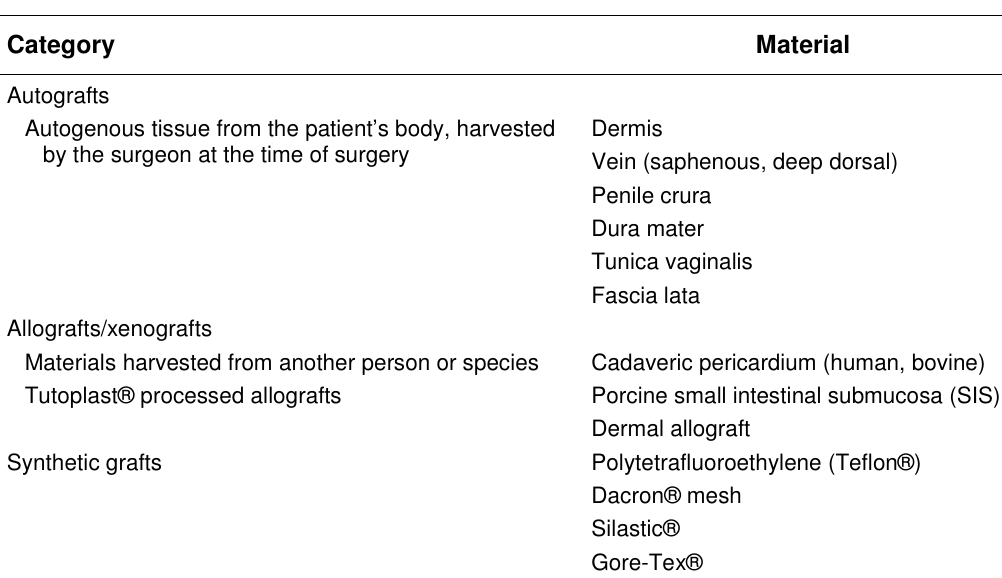
Graft Materials used to Cover Tunica Albuginea